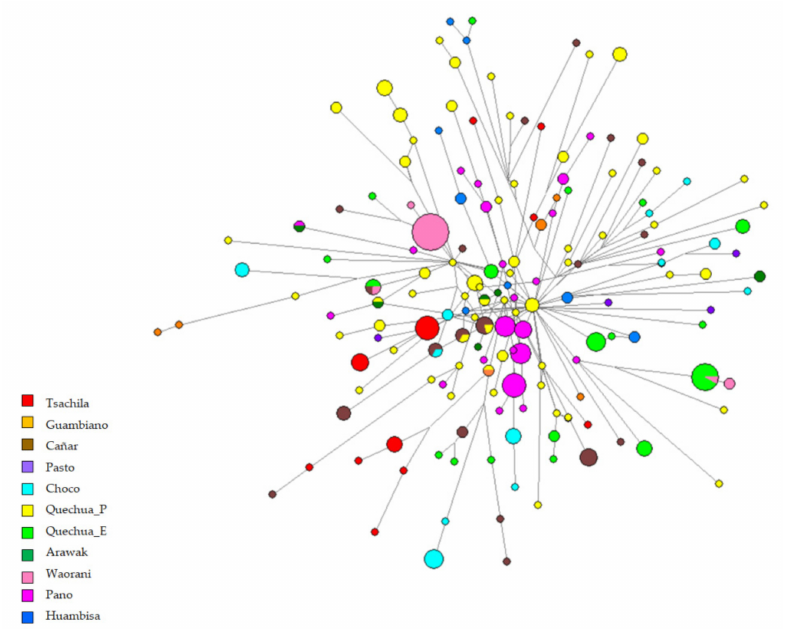
Figure 4. Median joining network for 14 Y-STRs haplotypes ( n = 316) among Peruvian, Ecuadorian, and Colombian populations, color-coded by ethnicity/linguistic affiliation. The haplotypes are represented by circles with sizes proportional to the number of individuals and branch lengths proportional to the number of mutational steps. The Quechua populations are divided by country (Peruvian and Ecuadorian Quechua are indicated by Quechua_P and Quechua_E,